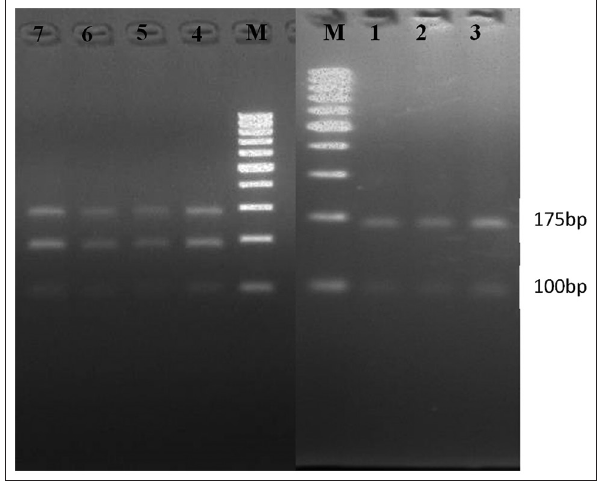
Figure-3: Restriction fragment length polymorphism (RFLP) analysis for polymerase chain reaction (PCR) products. Lane M: 100 bp marker, lanes 1-3: RFLP analysis for PCR product digested by TaqI (samples from North Egypt), and lanes 4-7: RFLP analysis for PCR product digested by TaqI (samples from South